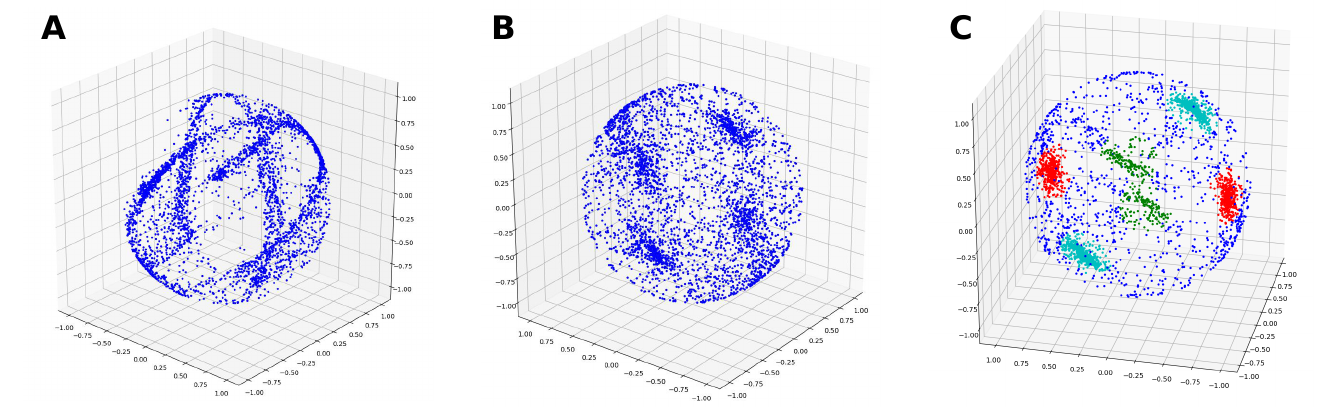
Figure 3. Sampling of cylinder axes. ( A ) Mapping of smoothed normals to a Gaussian sphere, for an example fork. ( B ) Cylinder axes identified using Pipe-run (random sampling). ( C ) Cylinder axes identified using our sampling approach. All rings are represented by well-separated clusters, including the ring with missing